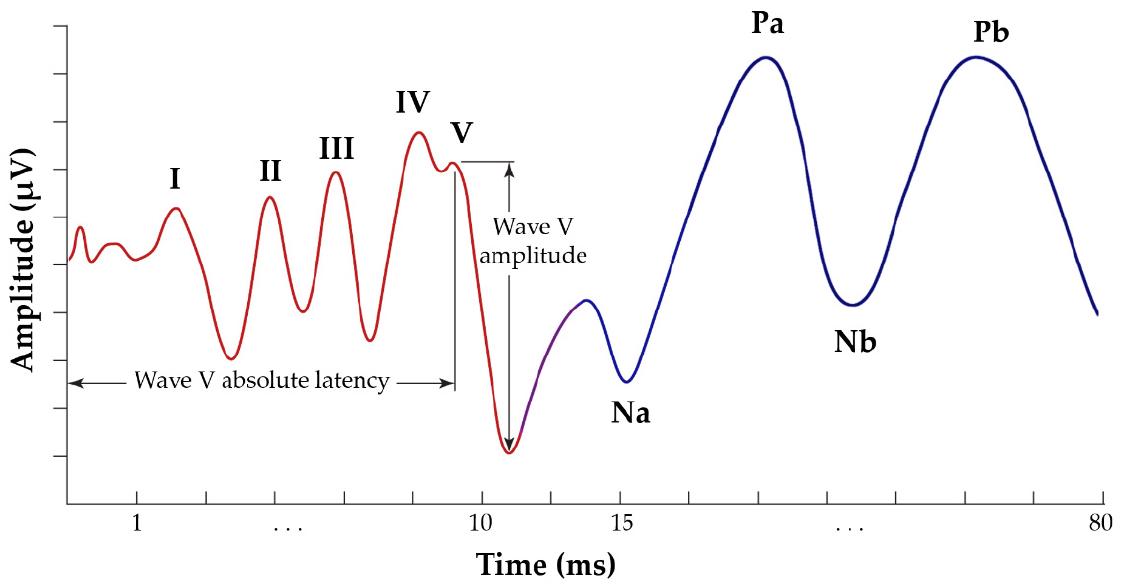
Figure 1. Typical annotated ABR signal, presenting the five waves of interest, from I to V (red waveform) and AMLR signal, presenting the four waves of interest, Na, Pa, Nb and Pb (blue waveform). The AMLR may be captured using the same equipment as the ABR. AMLR is generally recorded during a temporal frame of 80 to 100 ms, occurring between approximately 12 and 60 ms after the external stimulation. It is believed that the thalamus and auditory